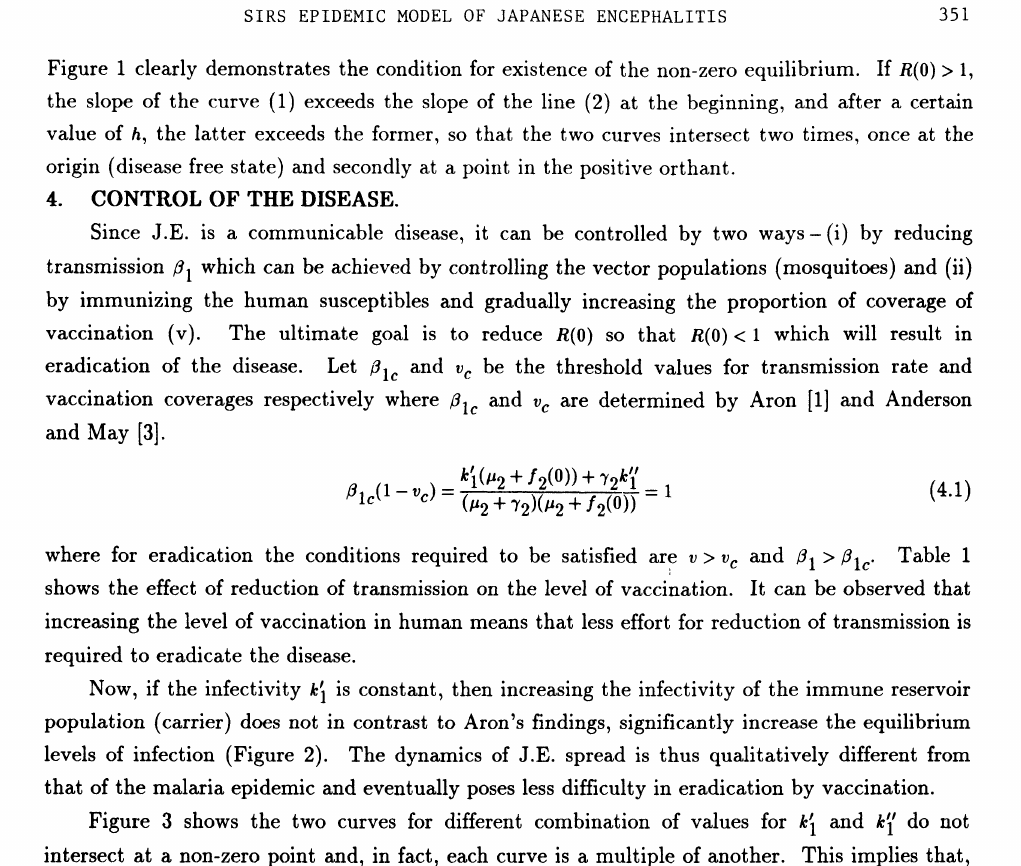
origin (disease free state) and secondly at a point in the positive